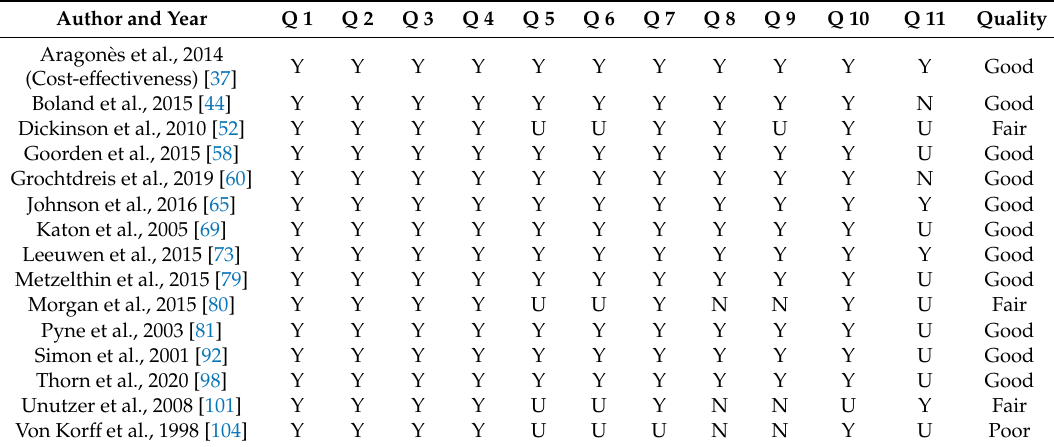
Table A7. Quality assessment of studies on economic evaluation using JBI critical appraisal checklist.